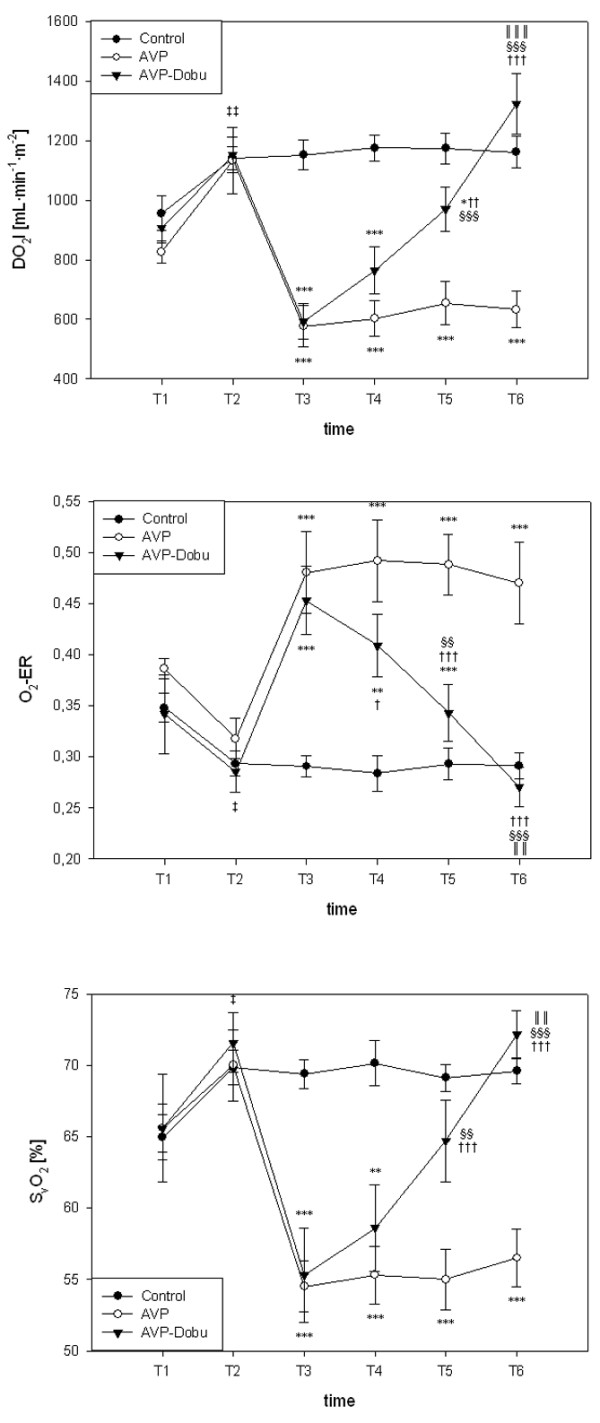
Changes in oxygen delivery index (DO2I), oxygen extraction rate (O2-ER) and mixed-venous oxygen saturation (SvO2). AVP, arginine vasopressin; AVP-Dobu, group treated with AVP and dobutamine; T1 = healthy baseline, T2 = endotoxemic baseline, T3 = AVP or placebo, T4, T5, T6 = AVP + dobutamine 2, 5 and 10 μg.kg-1·min-1 or placebo, respectively, *p < 0.05 versus control, **p < 0.01 versus control, ***p < 0.001 versus control, †p < 0.05 versus AVP, ††p < 0.01 versus AVP, †††p < 0.001 versus AVP, ‡p < 0.05 versus T1, ‡‡p < 0.01 versus T1, §§p < 0.01 versus T4, §§§p < 0.001 versus T4, ∥∥p < 0.01 versus T5, ∥∥∥p < 0.001 versus T5.